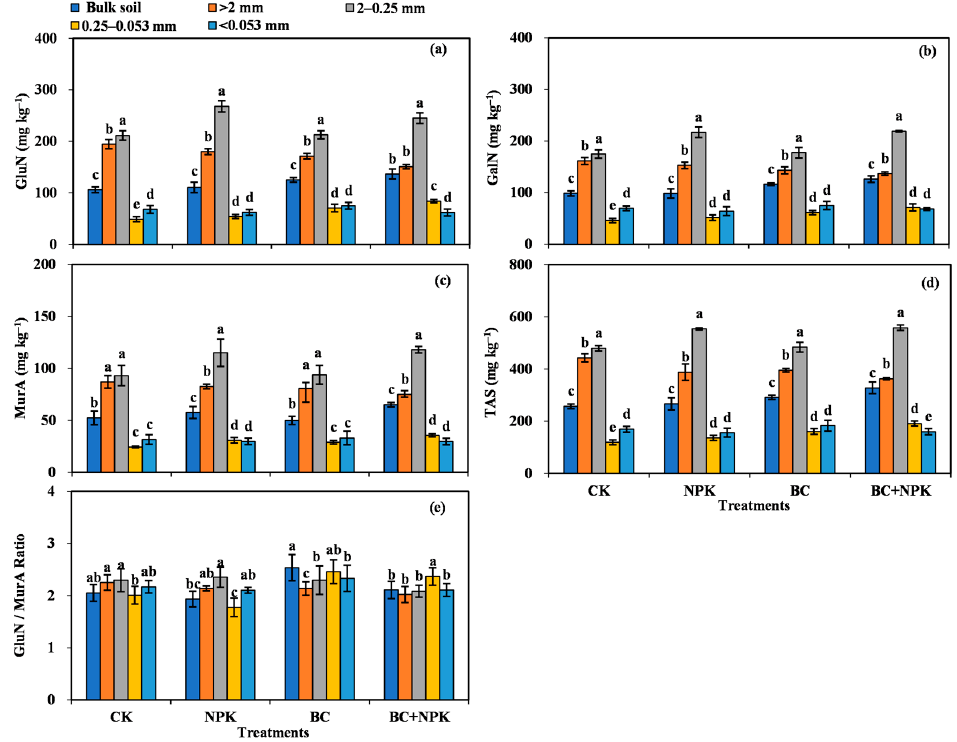
Figure 1. Contents of amino sugars in bulk soil and aggregates among different treatments ( a – e ). Diverse lowercase letters denote significant differences ( p < 0.05) among different particle sizes of bulk soil and every fraction. Abbreviations: GluN, glucosamine; GalN, galactosamine; MurA, muramic acid; TAS, total amino sugars.